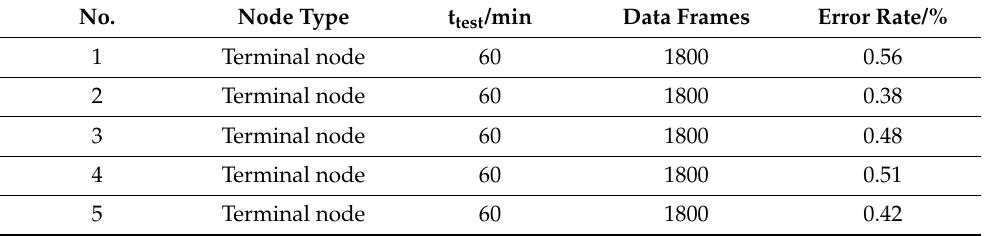
Table 7. Bit error rate